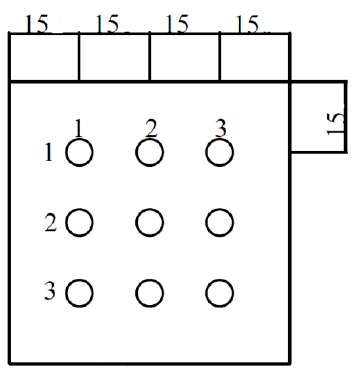
Figure 2. Location of the measuring points during airflow velocity test.